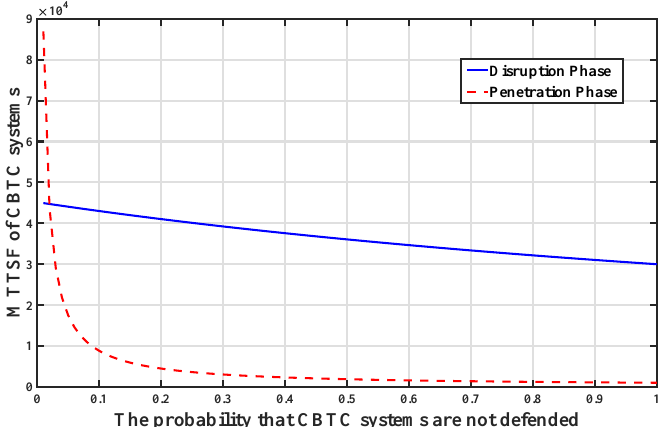
Figure 9. The defense scheme impact on CBTC mean time to security failure (MTTSF).